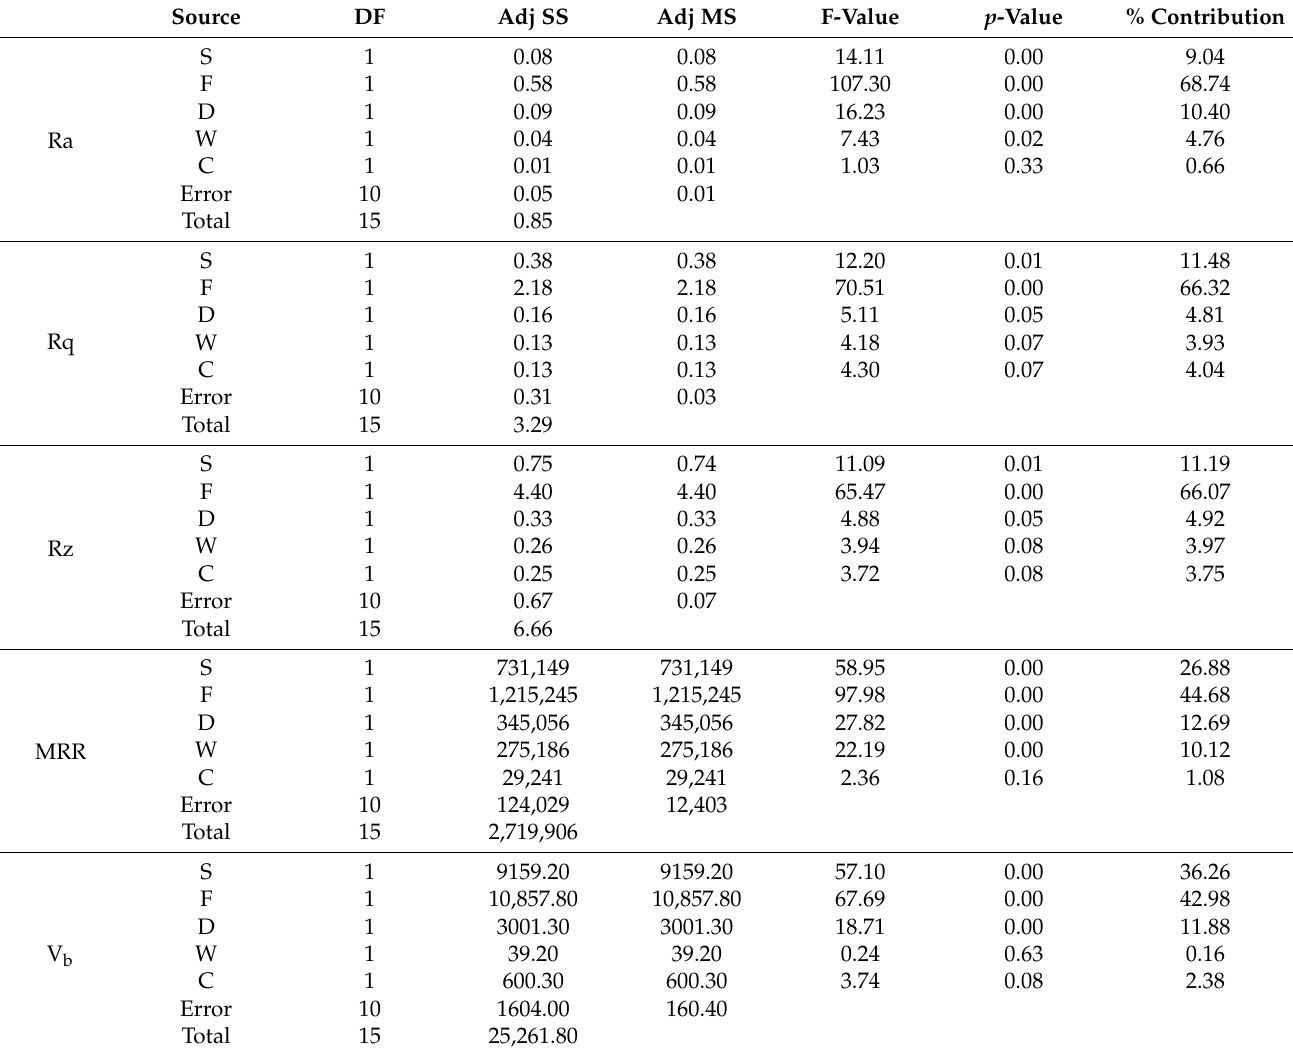
Table 5. ANOVA for individual quality